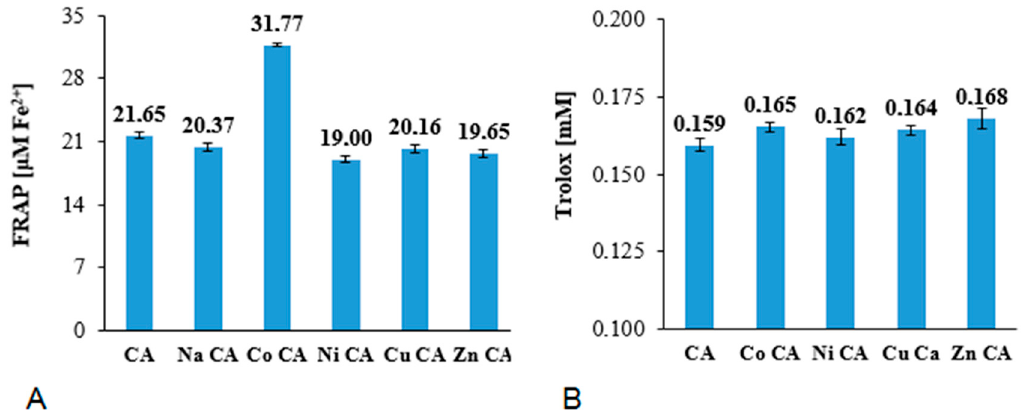
Figure 7. Antioxidant activity measured in ferric-reducing antioxidant power (FRAP) ( A ) and cupric-reducing antioxidant capacity (CUPRAC) ( B ) assays of cichoric acid (CA) and its metal compounds at the concentrations of 6 μ M.